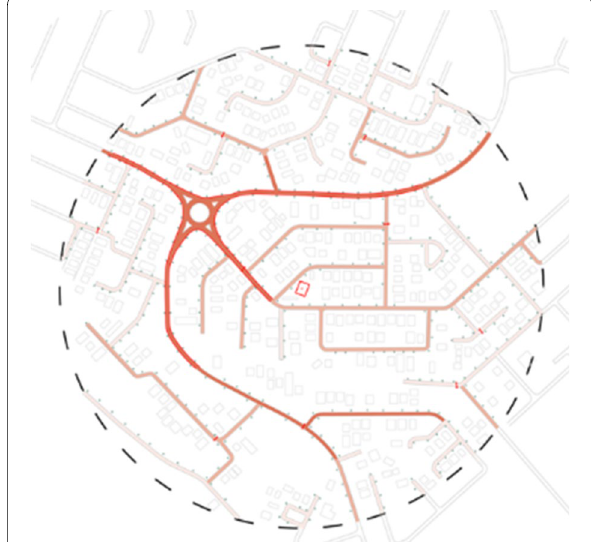
Fig. 4 The follwing map corresponds to the questions on safety in the neighborhood of Al Ansab. (The previous three maps were developed by Students in the WS course Urban Design 2 in 2019, GUTech IP owner for research